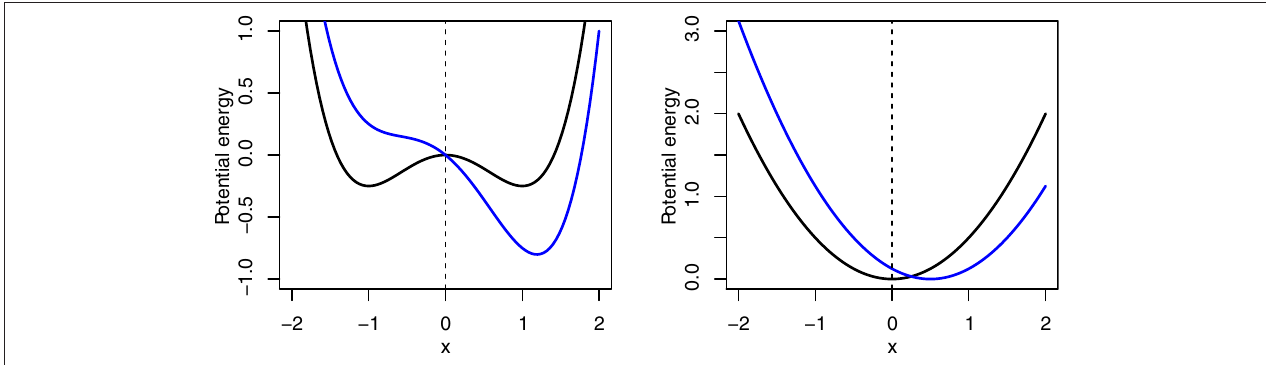
FIGURE 7 | Potential energy functions of system with two attractors (left) and system with one attractor (right). Black line: control parameter k = 0. Blue line: control parameter k = 0.5.